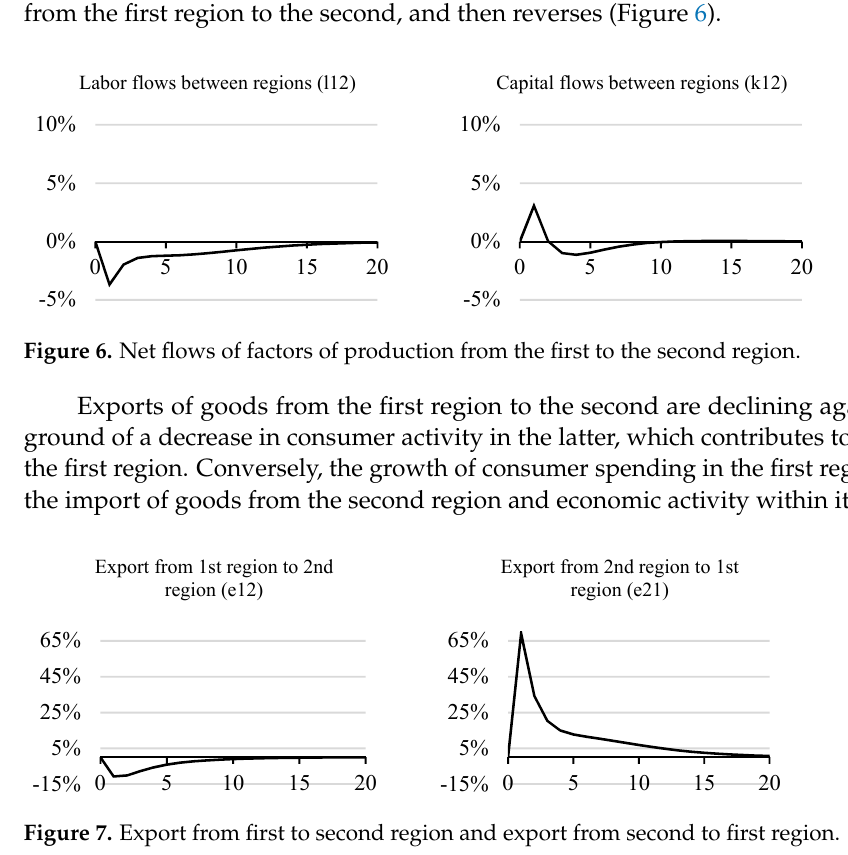
Figure 5. Interest rate fluctuations and loss of fixed assets in the first region. As a result of the growth of wages in the first region and a decrease in the second, labor resources flow from the second region to the first. Capital, on the contrary, first moves from the first region to the second, and then reverses (Figure 6).